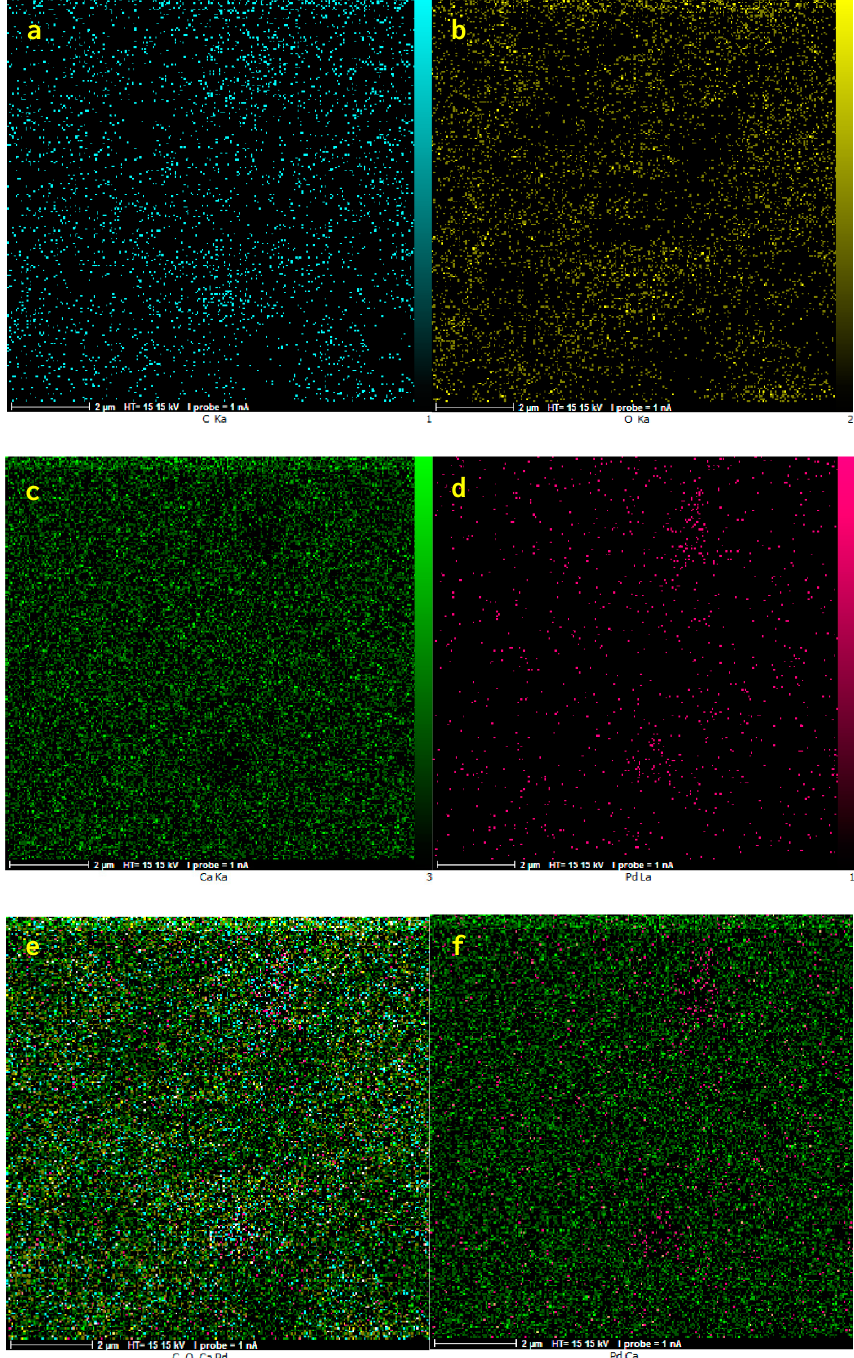
Figure 8. EDS elemental mapping of Pd/coral reef nanocomposite ( a : C; b : O; c : Ca; d : Pd; e : C, O, Ca and Pd; f : Pd and Ca).